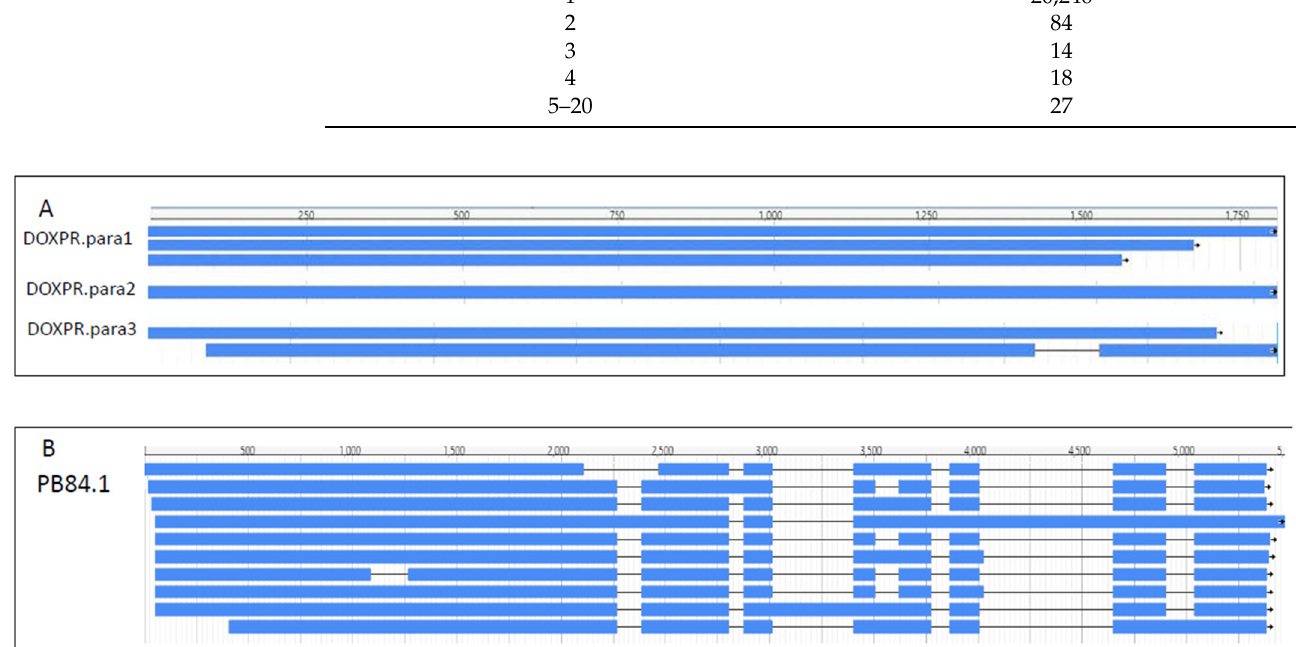
Table 3. Distribution of number of paralogs in the transcriptome of E. maculata. Number of Paralogs